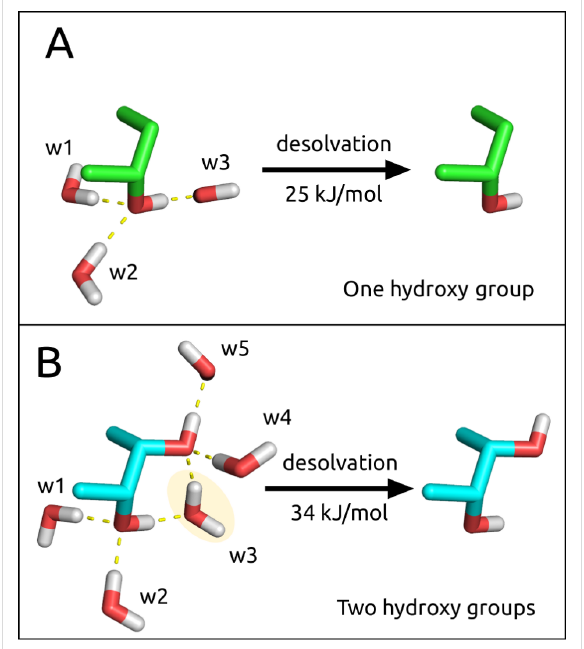
Figure 4: Desolvation of hydroxy groups. A) The desolvation cost of a single hydroxy group associated with three water molecules is Δ G = 25 kJ/mol, as calculated by Cabani et al. [61]. B) the desolvation cost of two adjacent hydroxy groups associated with five water mole- cules is Δ G = 34 kJ/mol, as opposed to 50 kJ/mol (equal to twice 25 kJ/mol). This can be explained by water w3, which is shared be- tween the two hydroxy